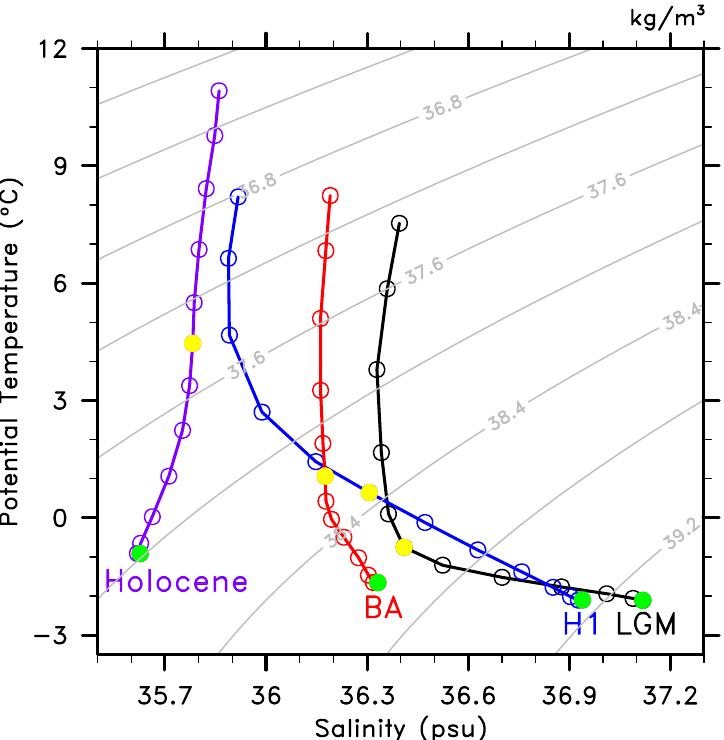
Figure 10. Atlantic basin-average T-S profiles (with depth) during the LGM (22 ka BP, black), H1 (17 ka BP, blue), BA (14.2 ka BP, red) and early Holocene (10 ka BP, purple). NADW is denoted at 1475 m (solid yellow dots) while AABW is denoted at 4751 m (solid green dots). For each profile, only the part below 326 m is shown. Contours of constant potential density are shown in